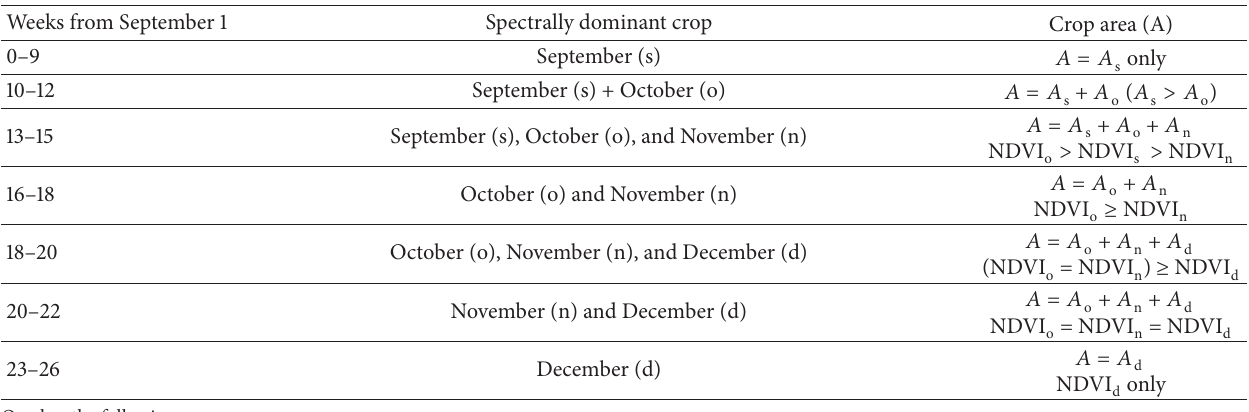
Table 7: Optimum times for discriminating crops for different planting